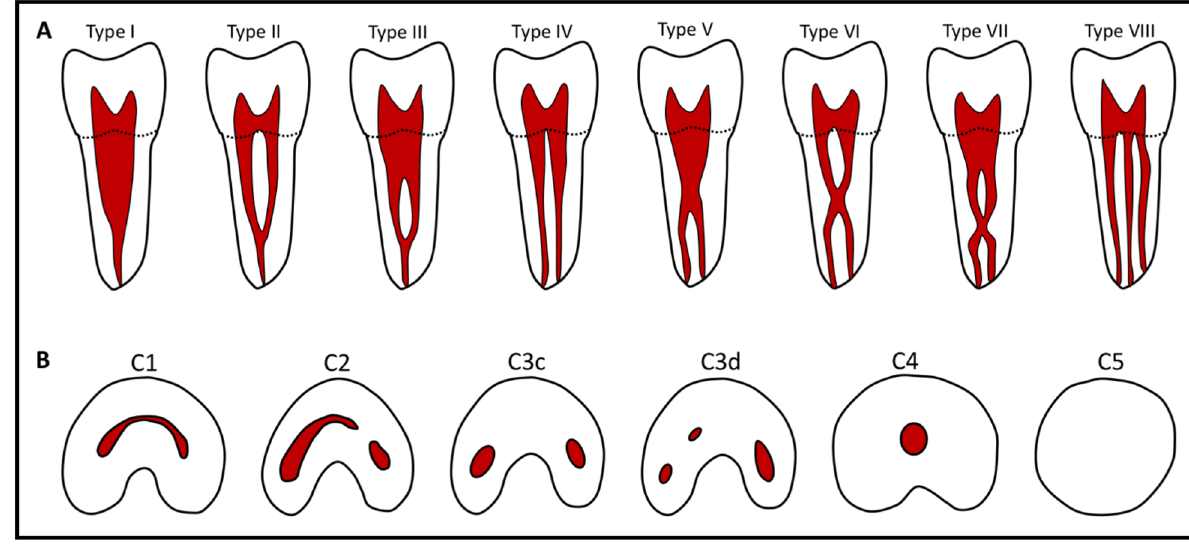
Figure 1. Illustration of ( A ) Vertucci classification of root canal system and ( B ) Fan et al. classification of C-shaped canal configuration.